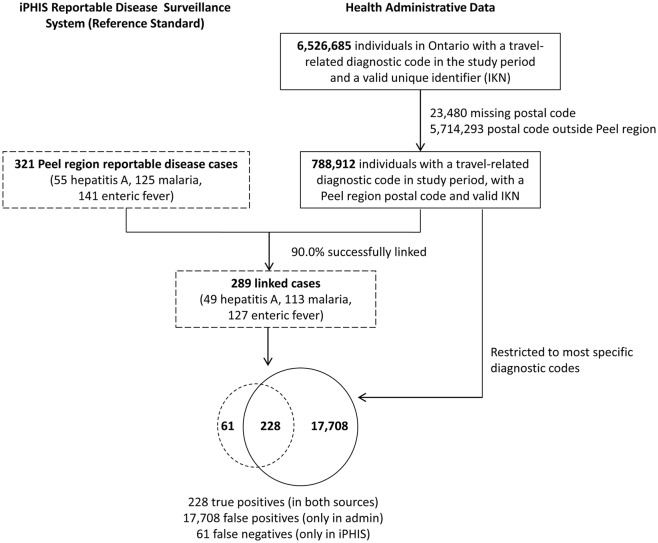
Study flow chart.